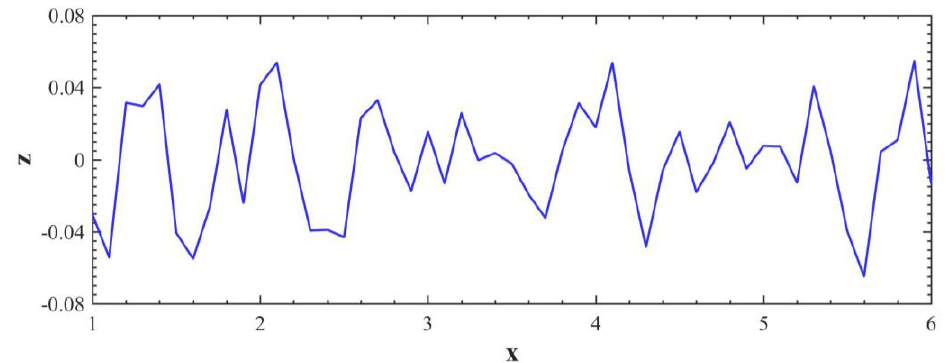
Figure 7. Schematic of fractal surface profile.